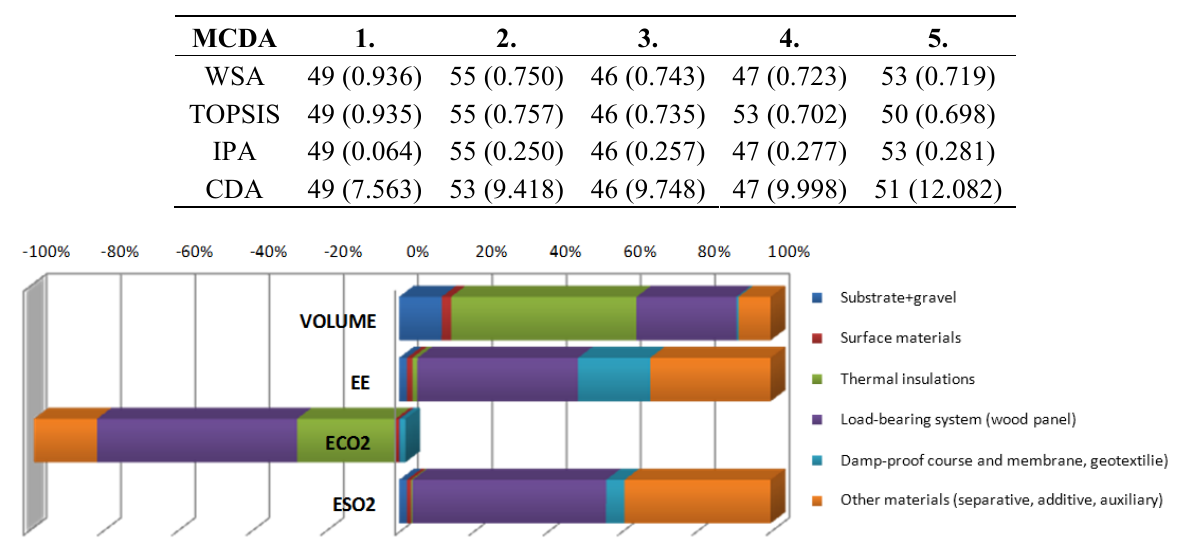
Table 14. Final MCDA scores for overall evaluation of roof structures.